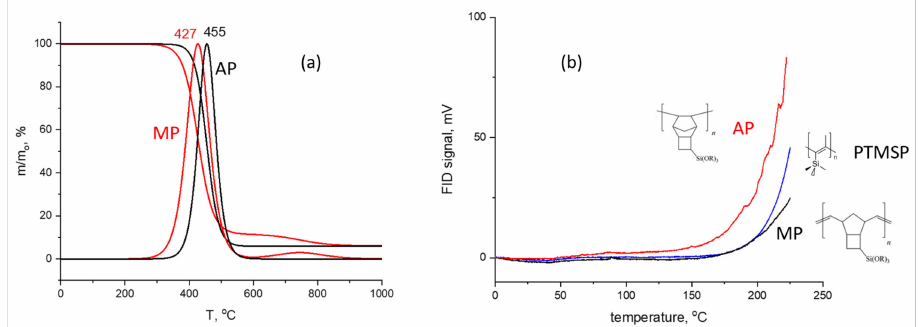
Figure 2. TGA curves demonstrating the percentage mass loss of the polymers depending on the temperature ( a ) and baseline stability under GC conditions of the AP and MP stationary phases and the PTMSP stationary phase ( b